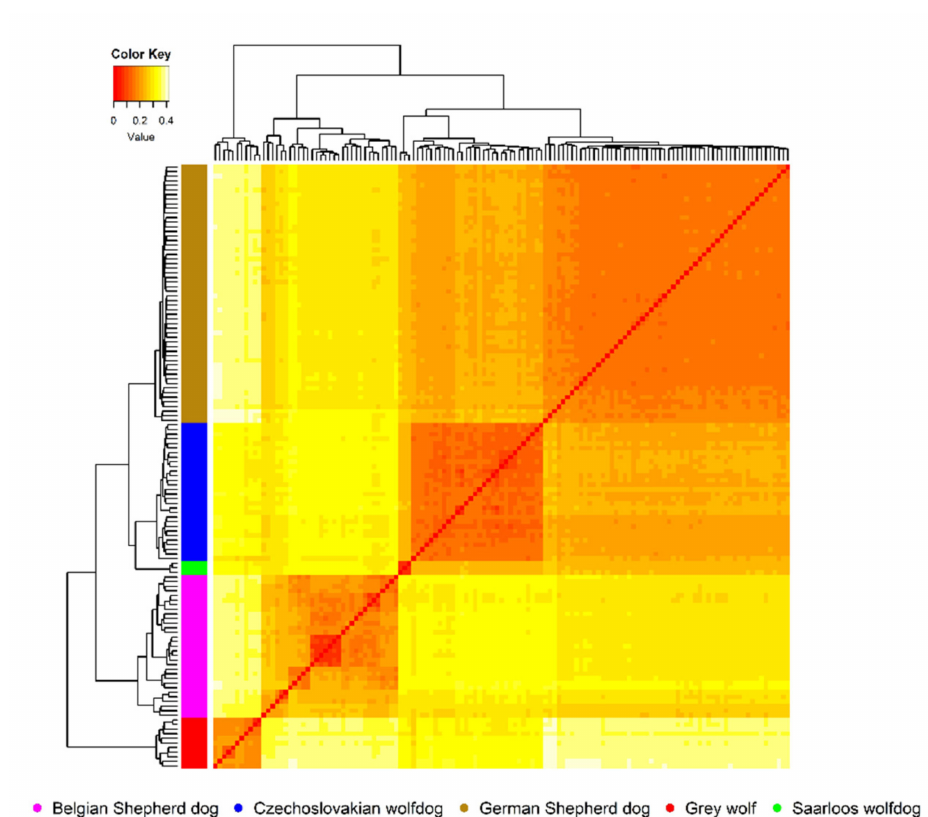
Figure 2. Detailed insight on an intrapopulation genetic structure derived from the Nei’s genetic distance matrix.